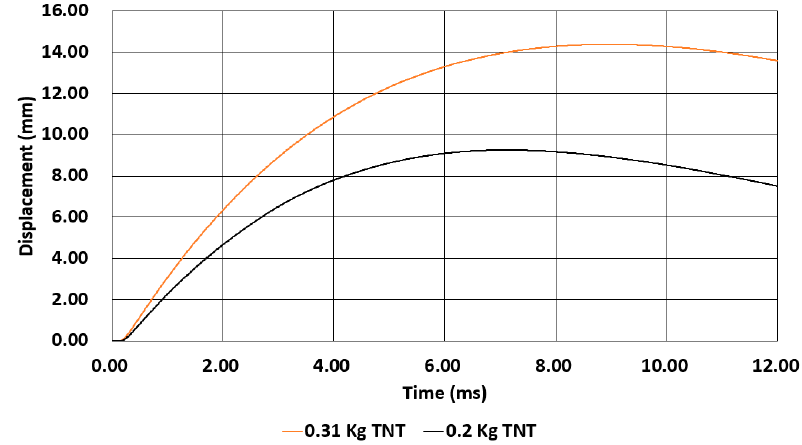
Figure 7. Displacement vs time graph from simulation results.